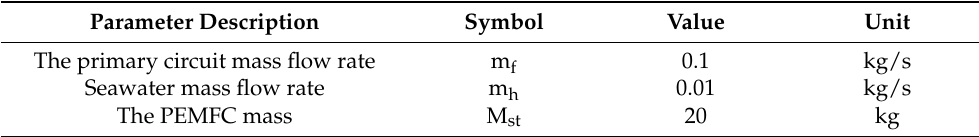
Table 6. The excluded parameters and their fixed